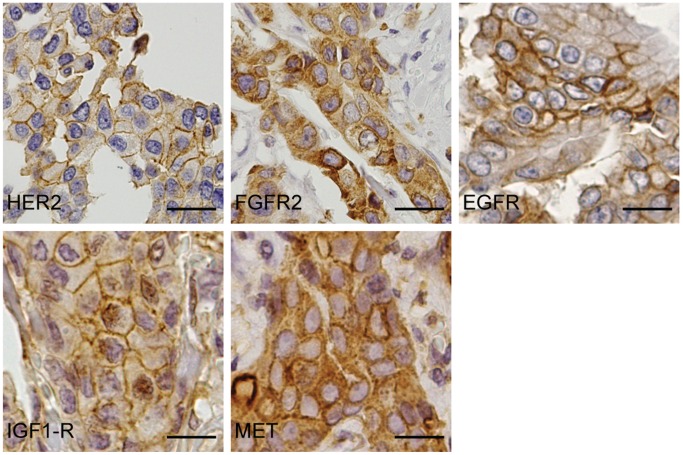
Expression of growth factor receptors in male breast cancer.Expression of HER2, FGFR2, EGFR, IGF1-R, and MET in representative cases of male breast cancer. Size bars equal 20 µm.